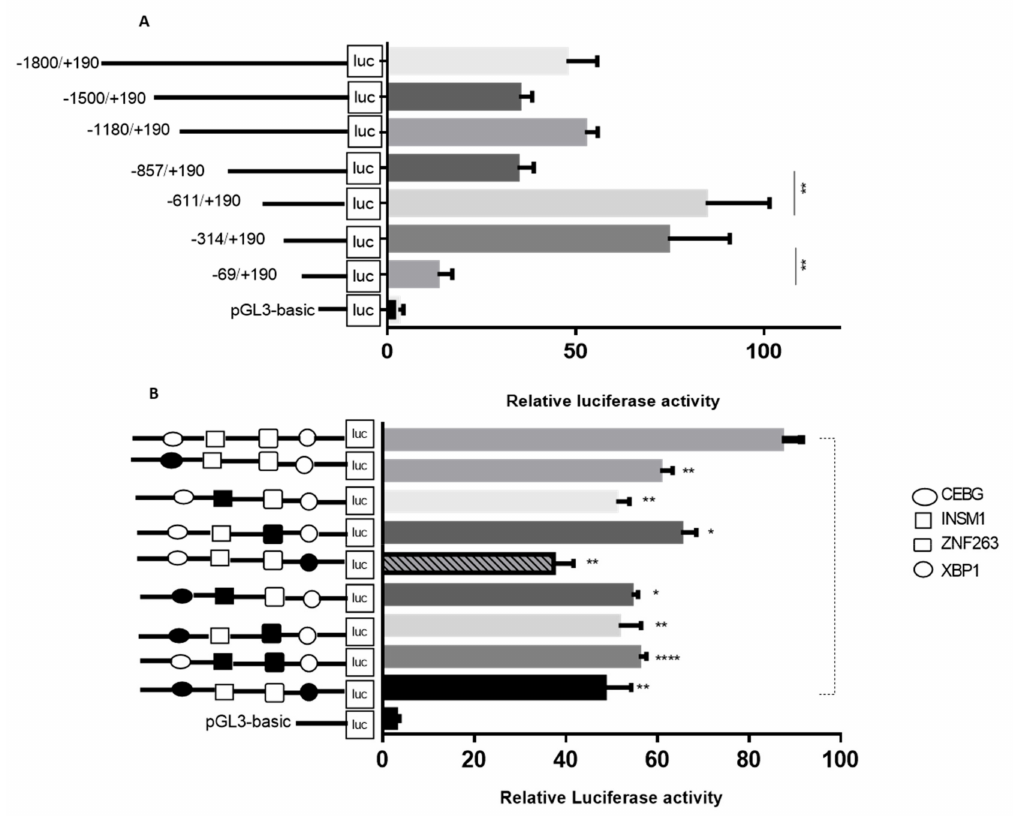
Figure 5. Luciferase reporter assay of the TORC2 promoter and identification of the transcription start site. ( A ) Transcriptional activity of promoter fragments TORC2-F1 (1990 − 1800 /+ 190), TORC2-F2 (1690 − 1500 /+ 190), TORC2-F3 (1370 − 1180 /+ 190), TORC2-F4 (1047 − 857 /+ 190), TORC2-F5 (801 − 611 /+ 190), TORC2-F6 (504 − 314 /+ 190), TORC2-F7 (259 − 69 /+ 190) and the pGL3-basic